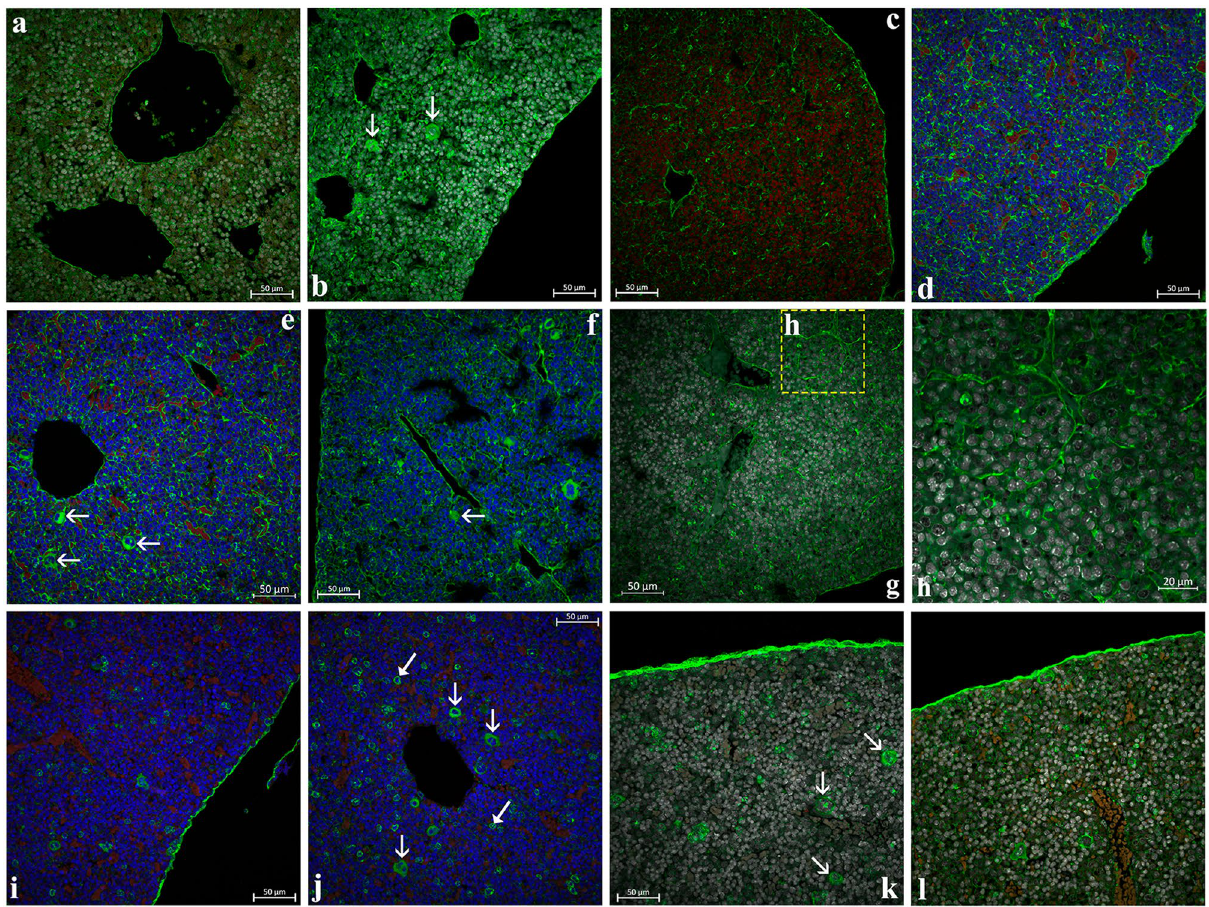
Figure 3. N-acetylglucosamine expression revealed by DSL ( a ), sWGA ( b,c ), WGA ( d–h ), STL ( i–k ), LEL ( l ). An average of five fetal livers per slidefrom E13.5 ( a,d-e,i–j ), E14.5 ( b,f,k,l ), and E16.5 ( c,g–h ) were analyzed in two independent experiments and representative images are shown. Megakaryocytes (arrow) intensely visualized by sWGA, WGA and STL. Capsule strongly express NAcGlu marked through STL. Some smaller cells of horseshoe shaped nucleus, probably neutrophils at band stage (triangle point arrow, fig ( j )). Green— AlexaFluor 488; white, blue or red ( c ) (pseudocolors)—DAPI; red ( d,e,i,j )—autofluorescence.